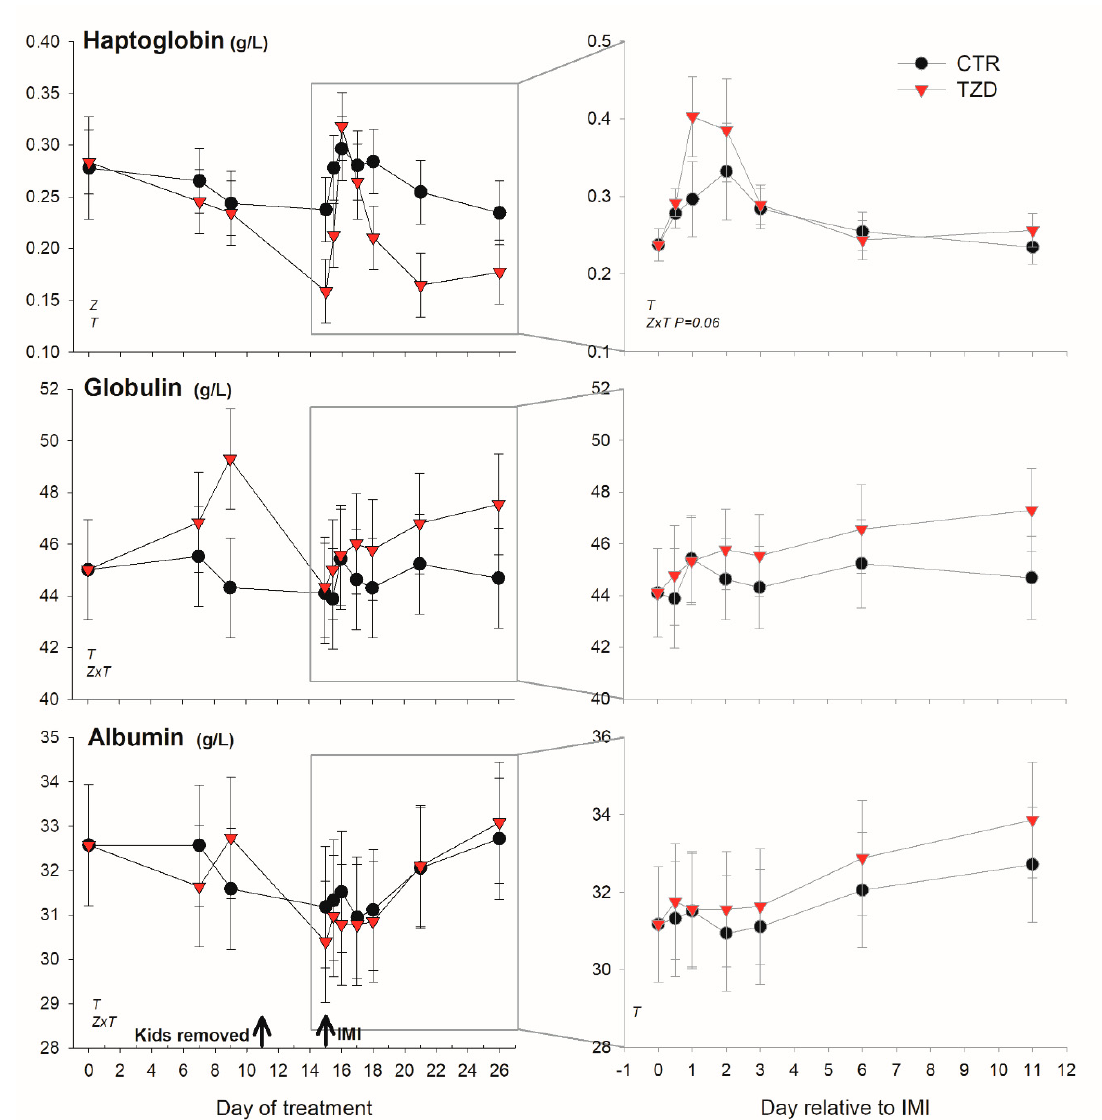
Figure 4. Effect on a positive (haptoglobin) and a negative (albumin) acute phase protein and globulin of daily injection of 2,4-thiazolidinedione (TZD) and saline (CTR) in Saanen dairy goats plus intramammary infusion in the right half of the mammary gland with Strep. uberis (IMI) while the left half of the mammary was left untouched (control). The left quadrants report the pattern of each parameter during the whole study. Arrows indicate time of kid removal and IMI. The quadrants on the right denote the pattern of the same parameters after IMI (with correction with baseline before IMI, see Materials and Methods). Overall statistical significance ( p ≤ 0.05) is indicated in the plot as follows: T = time effect; M = IMI effect; Z = effect of 2,4-thiazolidinedione injection.